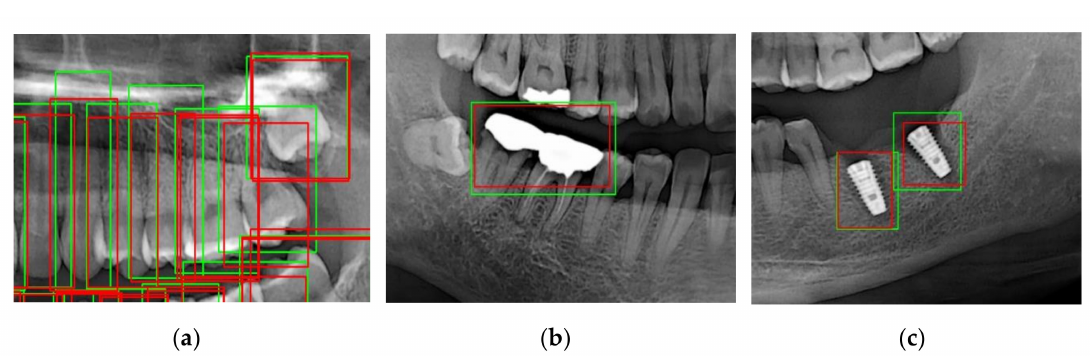
Figure 9. ( a ) Example of tooth, ( b ) crown, and ( c ) implant fixture detection.